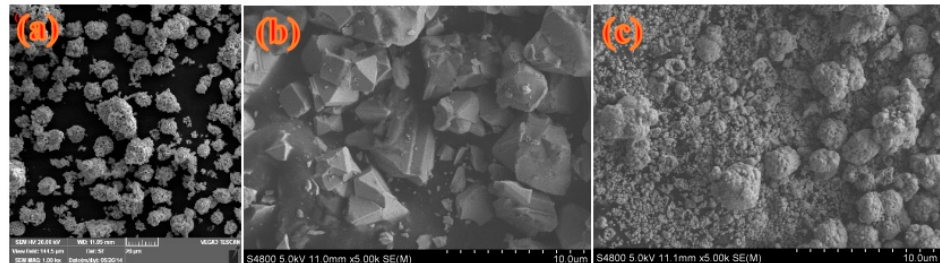
Figure 4. SEM (scanning electron microscopy) photographs of materials: ( a ) BiVO 4 , ( b ) Mn 1 − x Zn x Fe 2 O 4 , ( c ) BiVO 4 /Mn 1 − x Zn x Fe 2 O 4 (15 wt %).